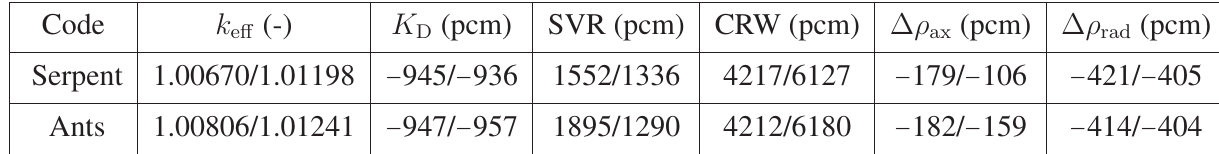
Table 3: 3D Full-Core Results for CA/OX with High-Fidelity and Reduced-Order